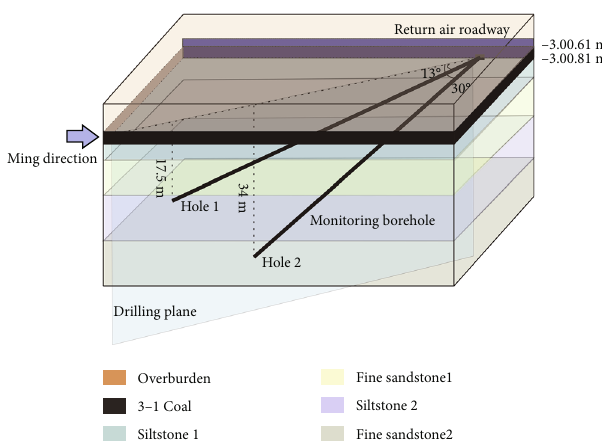
Figure 9: Layout of the monitoring